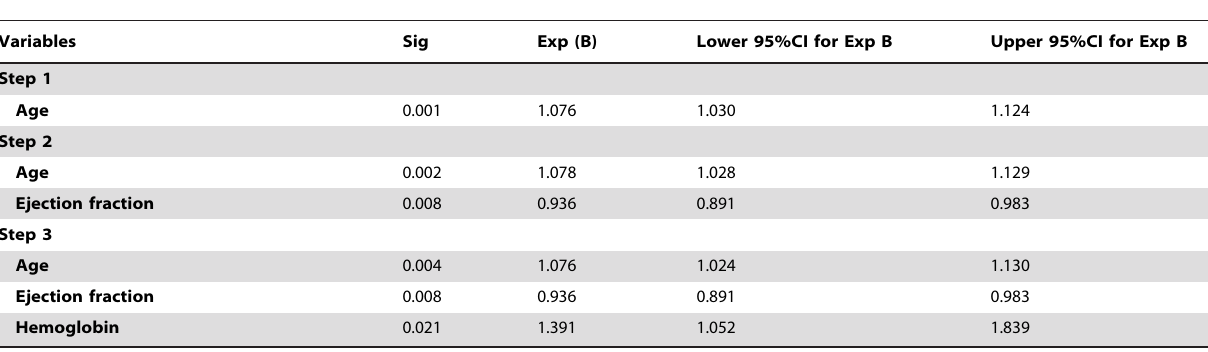
Table 3. Stepwise logistic regression analysis: Variables in the